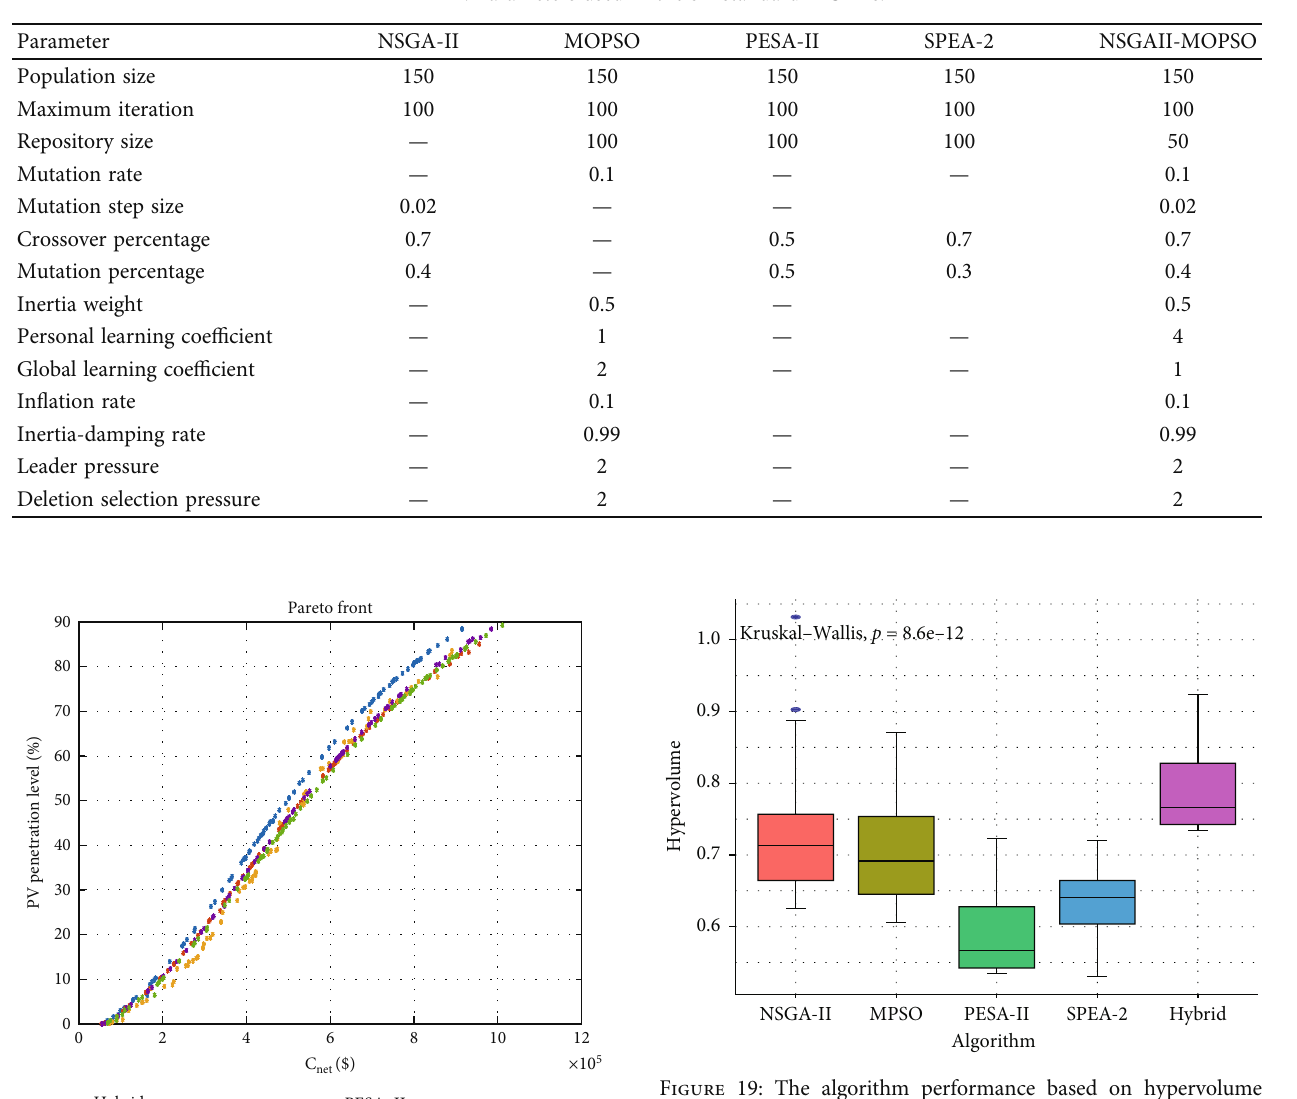
Table 4: Parameters used in the six standard MOEAs.